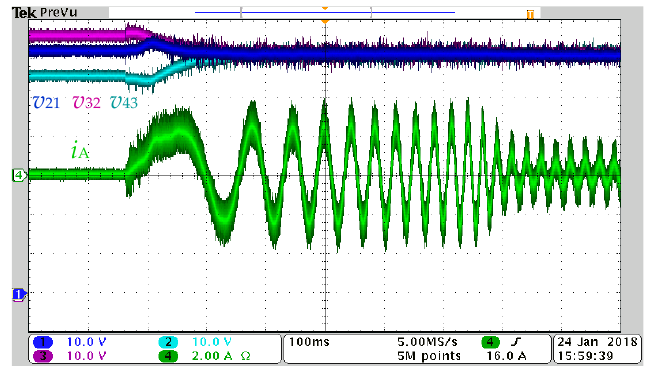
Figure 7. Experimental results of DC-link voltages and phase current i A under a start-up transition. Conditions: V dc = 180 V, C = 155 µ F, ω * = 500 rpm, k pω = 0.1 A/rpm, k iω = 0.1 A/(rpm·s), k pi = 0.01 A −1 , k ii = 1 (A · s) − 1 , k pv = 0.02 V − 1 , k iv = 0 (V · s) − 1 , t s = 100 µ s, load torque = 0 Nm.